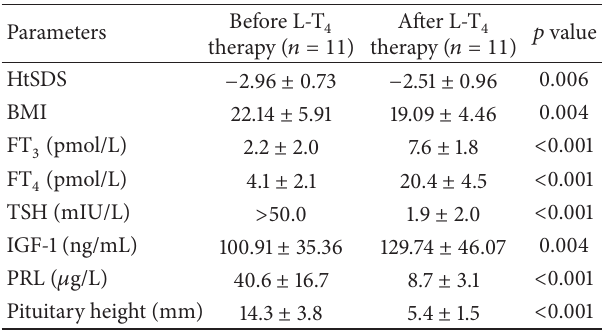
Table 2: Parameters in short-stature children with PPH accompa- nied by low GH levels before and after 3 months of L-T 4